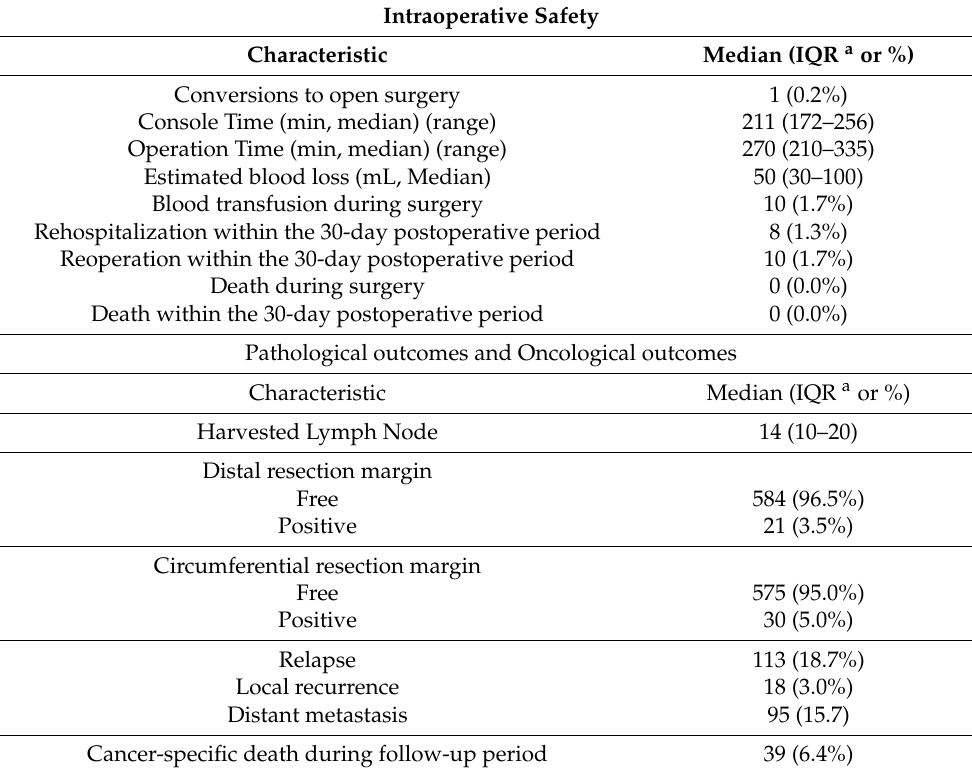
Table 2. Intraoperative Safety and Clinical Outcomes of 605 patients with rectal cancer undergoing robotic-assisted rectal